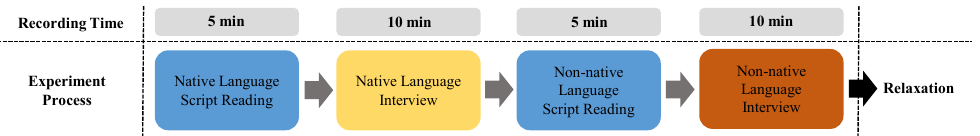
Figure 1. Progress of the designed stress-inducing experimental scenario, including the recording time for each